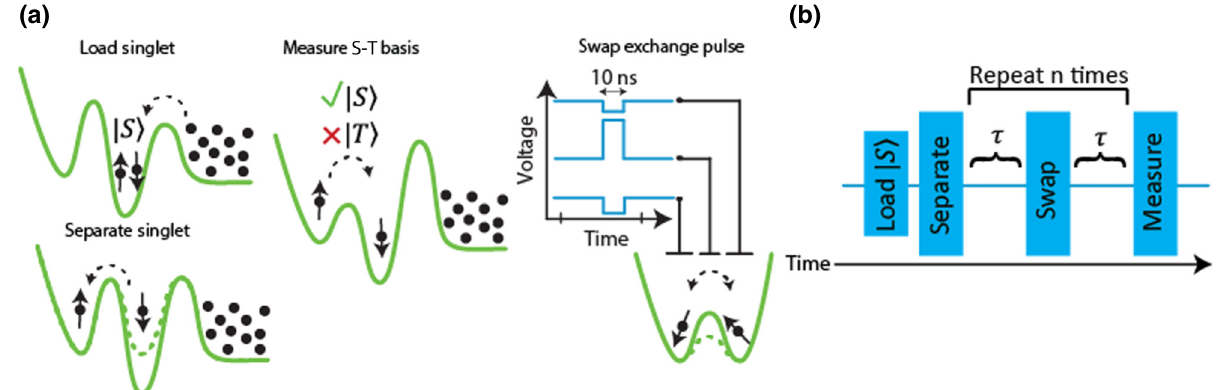
FIG. 2. (a) Schematic representation of double-dot initialization, single-triplet measurement, and pulsed exchange swaps. (b) Rep- resentation of the experimental protocol for Hahn echo ( n = 1) and Carr-Purcell- n experiments in our double-dot system.